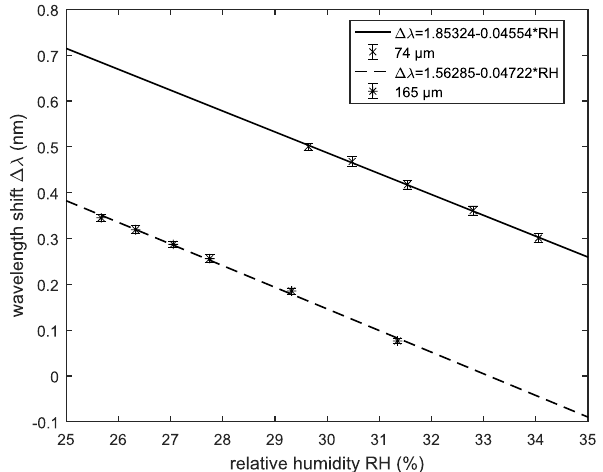
Figure 6. Wavelength shift ∆ λ as a function of relative humidity for arrays consisting of 74µm spheres and 165µm spheres, respectively. The slope of the curves is equal to the sensitivity.